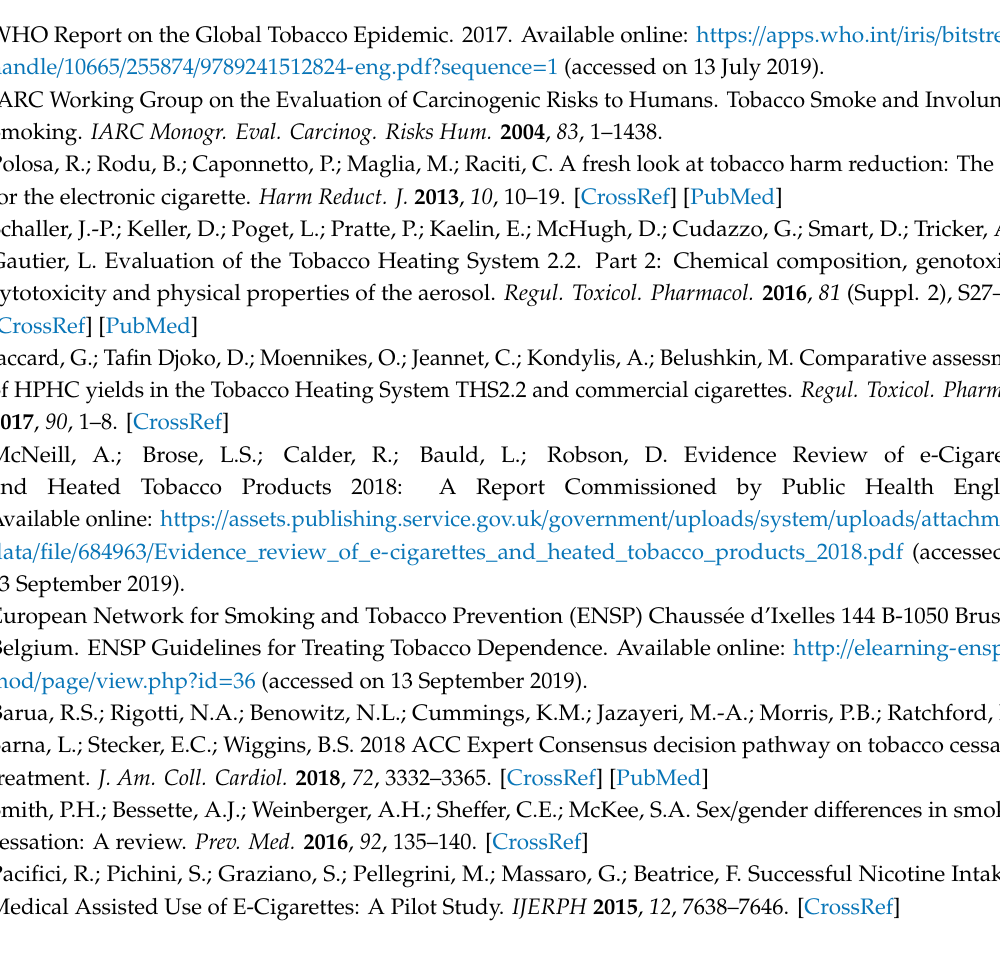
Figure S1: %COHb before and after switch; Figure S2: CO ppm before and after switch; Figure S3: Di ff erence %COHb before and after switch in the two groups; Figure S4: Di ff erence CO ppm before and after switch in the two